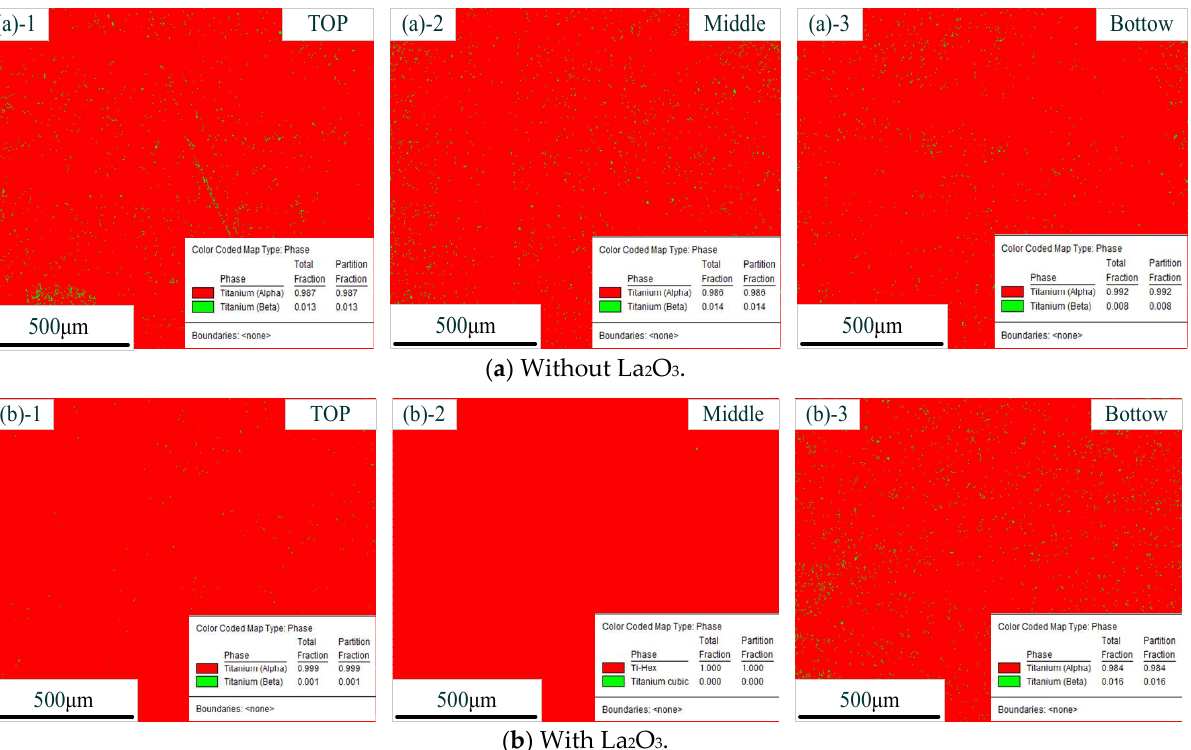
Figure 6. Distribution of phases without La 2 O 3 ( a ) and with La 2 O 3 ( b ). (Note: (a)-1 and (b)-1 show the top zone, (a)-2 and (b)-2 show the middle zone, and (a)-3 and (b)-3 show the Bottom zone)